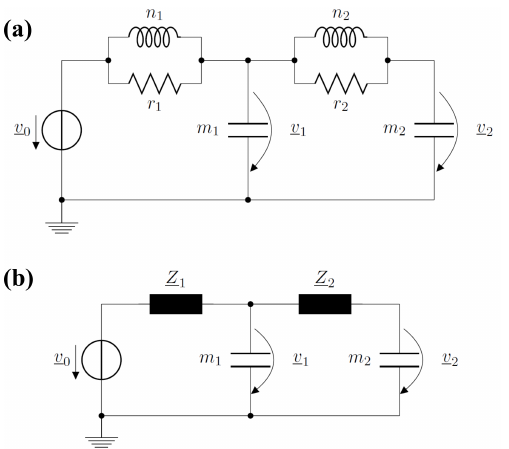
Figure 7. Circuit model with damping and without external inter- action, (a) complete, (b) with parallel branches combined into com- plex impedances Z 1 , 2